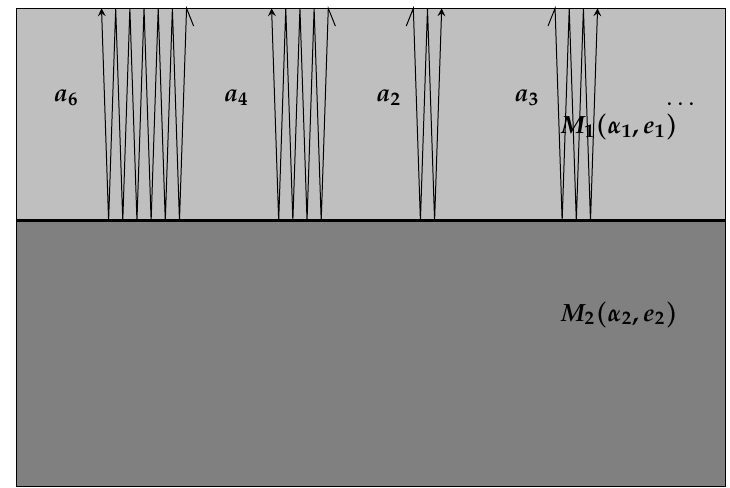
Figure 5. Waves that are reflected first at the interface between M 0 and M 1